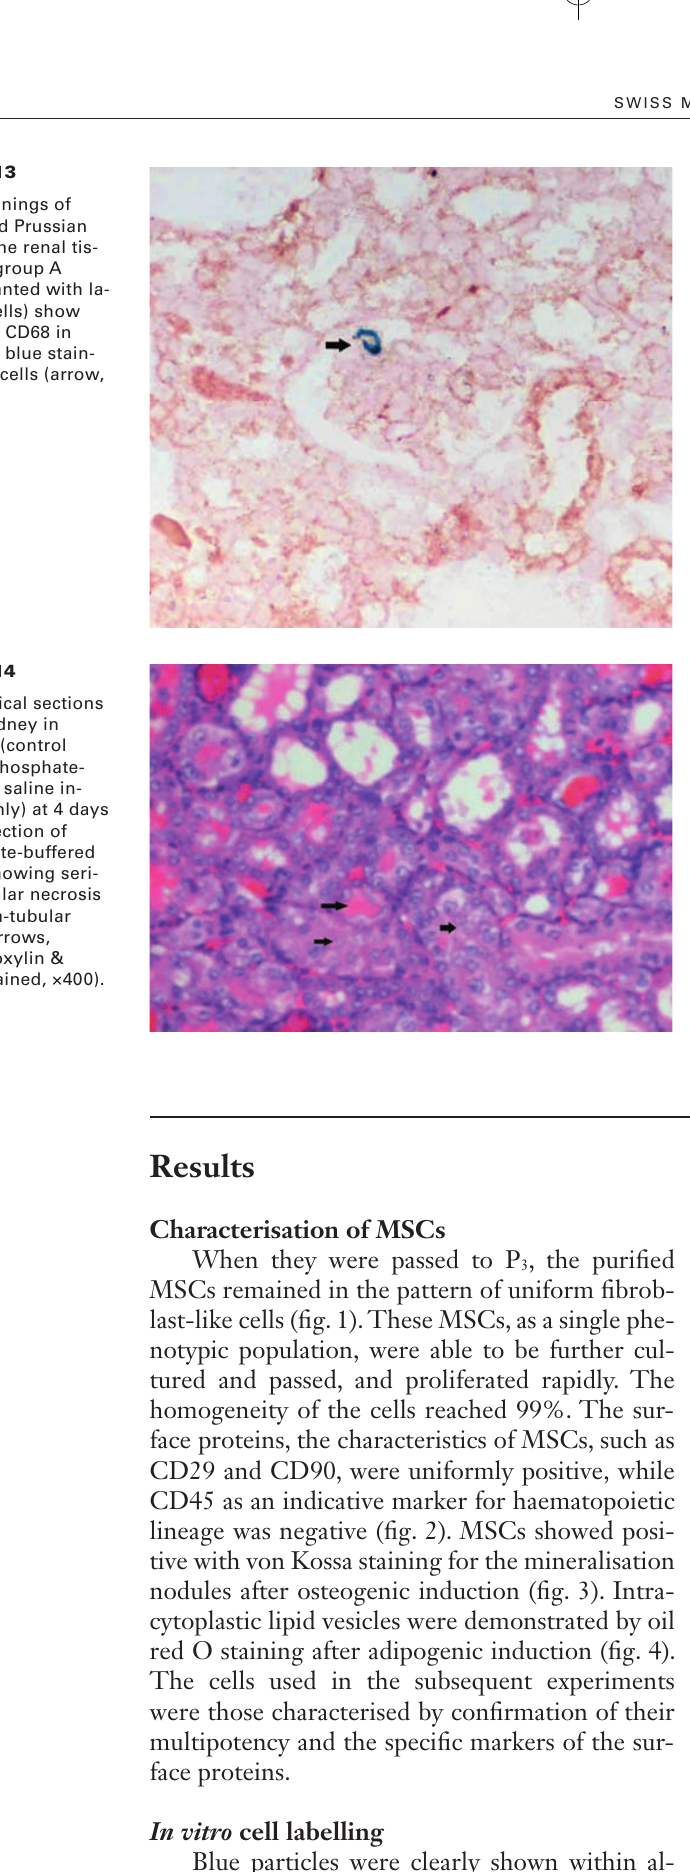
Dual stainings of CD68 and Prussian blue in the renal tis- sues of group A (transplanted with la- belled cells) show negative CD68 in Prussian blue stain- positive cells (arrow, ×100).